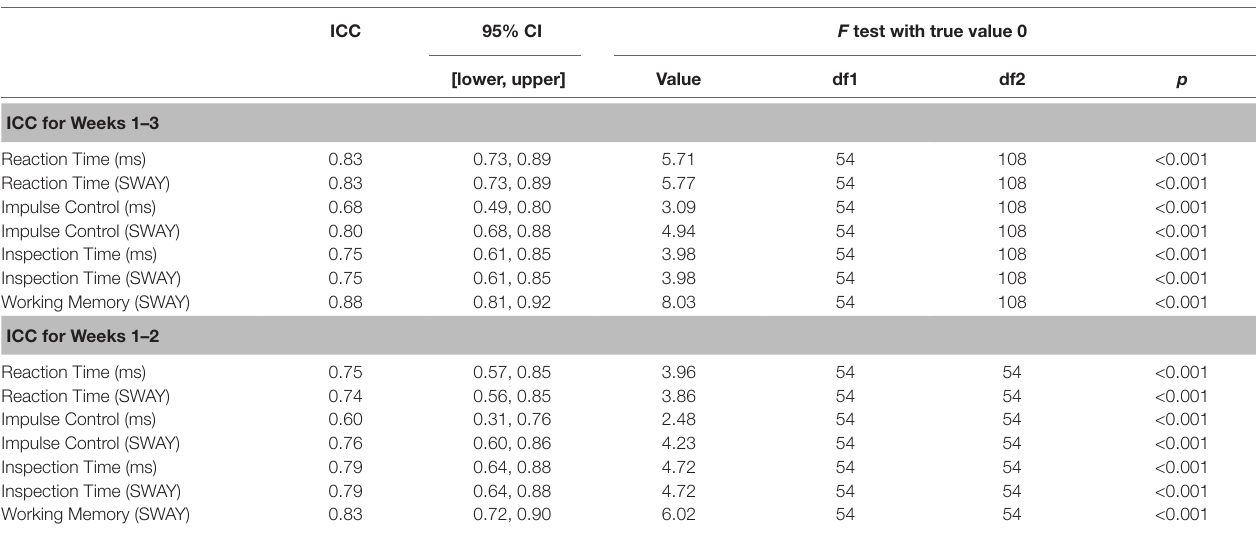
TABLE 3 | Test–Retest